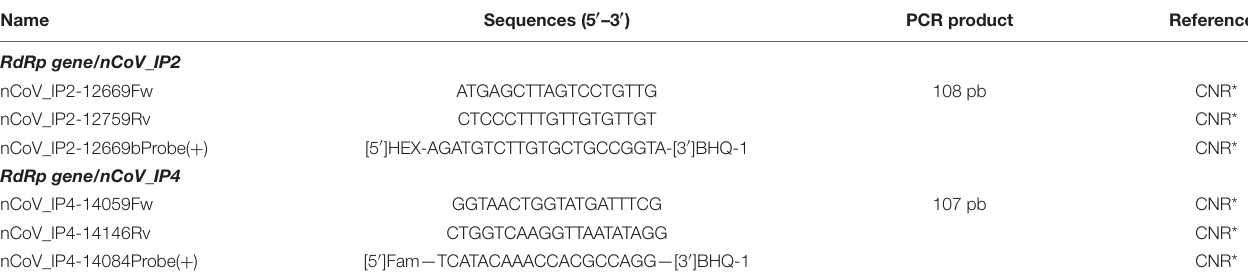
TABLE 1 | RT-PCR for the detection of SARS-CoV-2: primers and probes